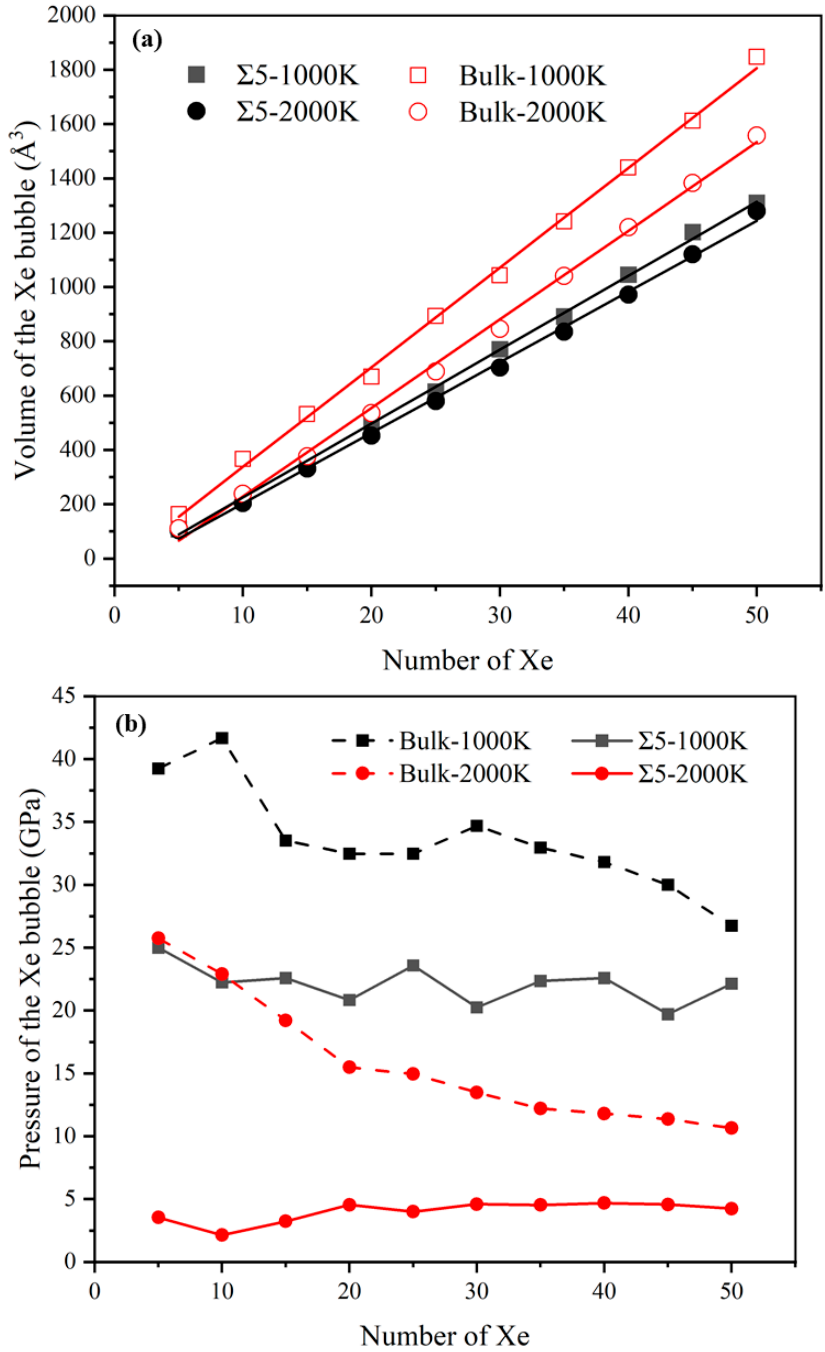
Figure 5. ( a ) Volume (Å 3 ) and ( b ) pressure (GPa) of Xe bubbles as a function of the number of Xe atoms in the bubbles. The lines are linear Arrhenius fits.